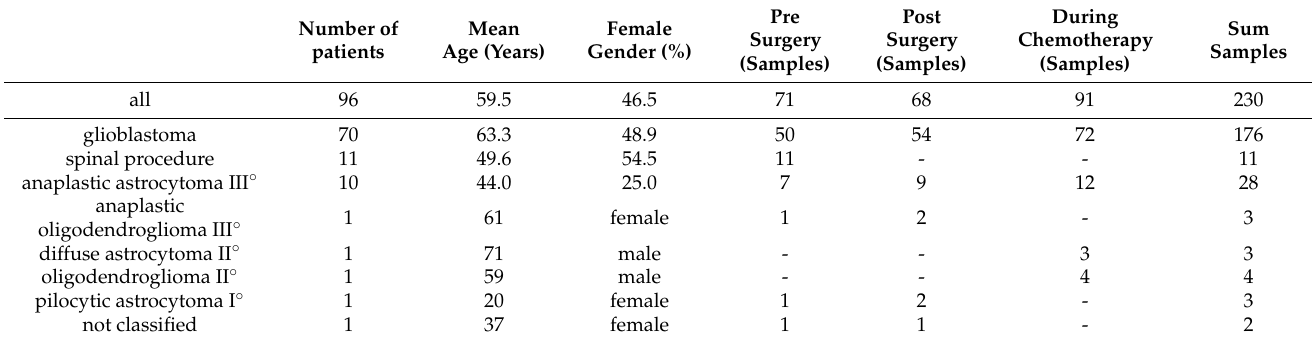
Table 1. Patient